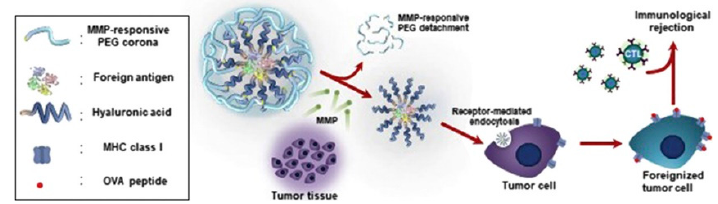
Figure 7. Representation of MMP9 responsive PEGylated HA-OVA targeted cancer immunotherapy. Reprinted with permission from Ref. [199]. 2017, Elsevier B.V.